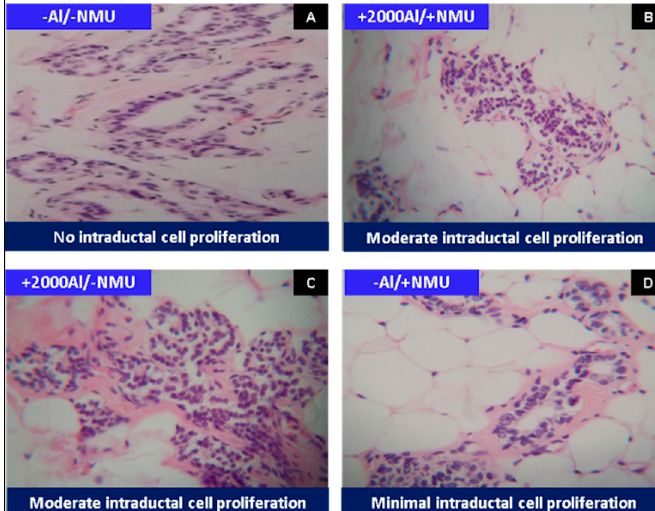
Figure 1. The histological change found in the breast tissue of Sprague Dawley rats is shown with the different treatments used. Hyperplasia of the breast ducts was minimal ( D ) to moderate ( B and C ). Normal/negative control ( A ). HEx400. Table 2. Genotoxicity caused by experimental treatments by micronucleus count (MN) in peripheral